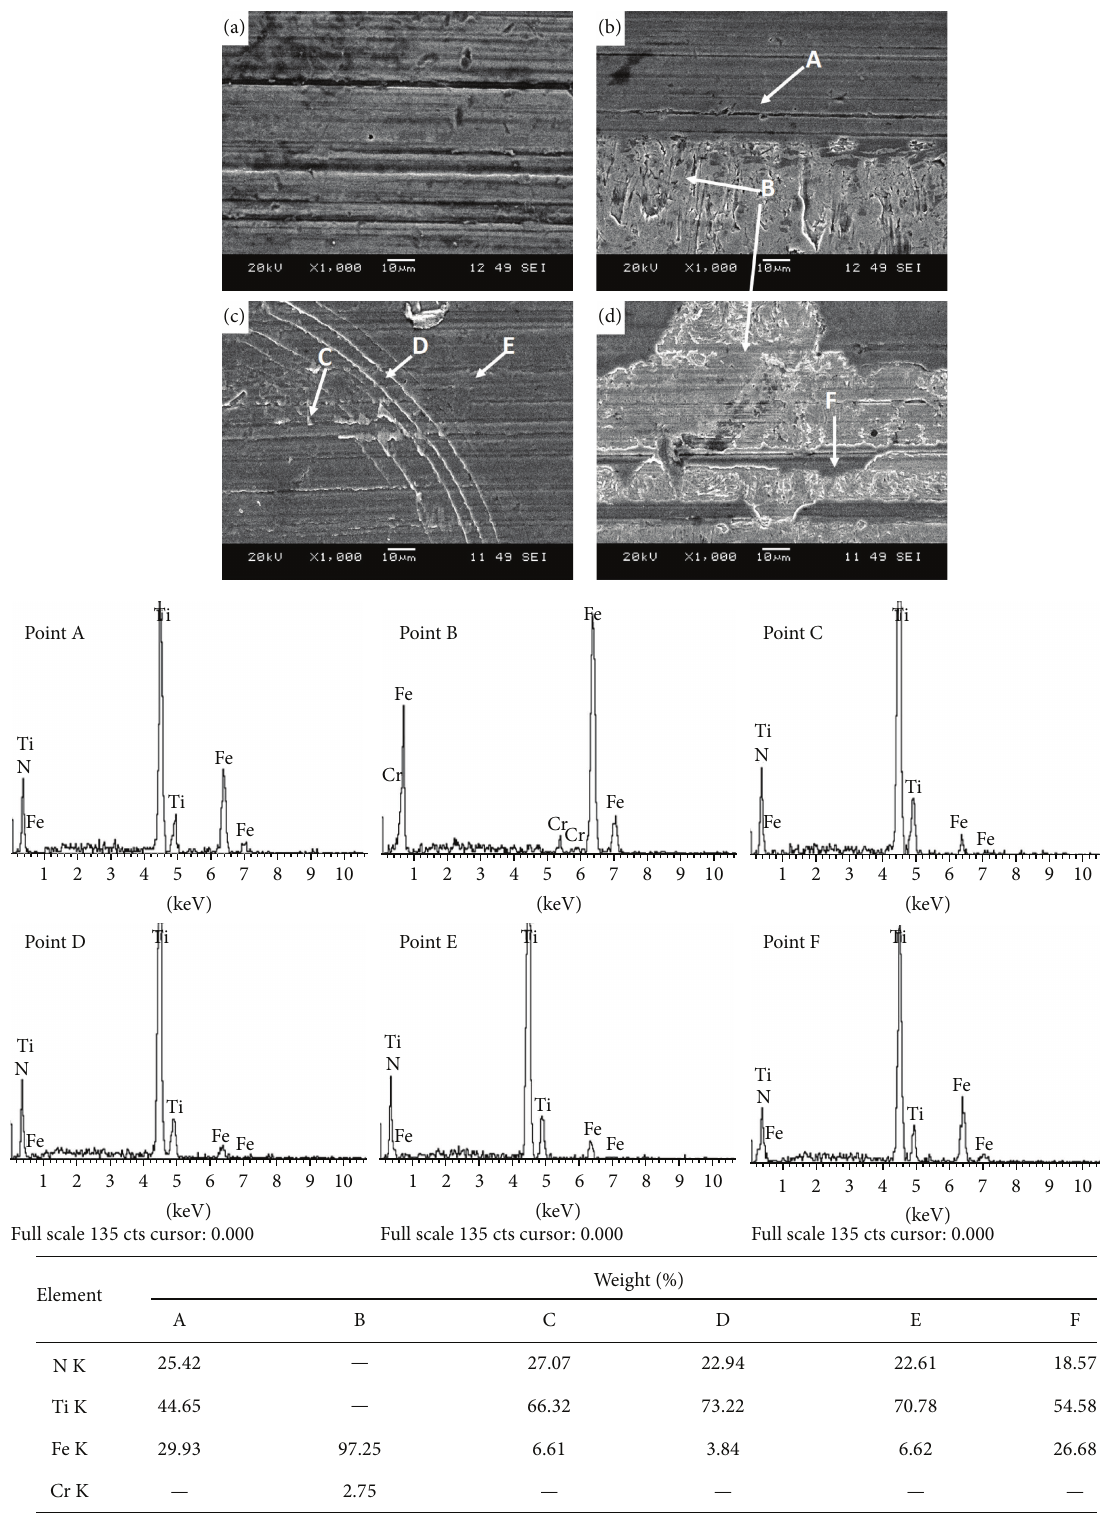
Figure 6: The SEM micrograph of nitrided+TiN gears after running test; (a) pitch line of driving gear, (b) edge of meshed zone of driving gear, (c) pitch line of driven gear, and (d) edge of meshed zone of driven